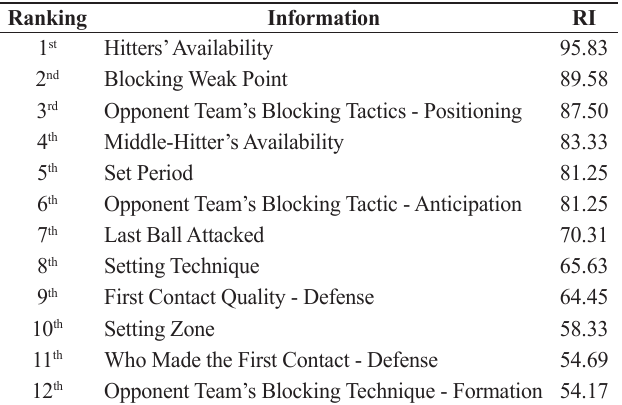
Table 5: Classification of information contained in the Counter-Attack Processes based on the response rate obtained.